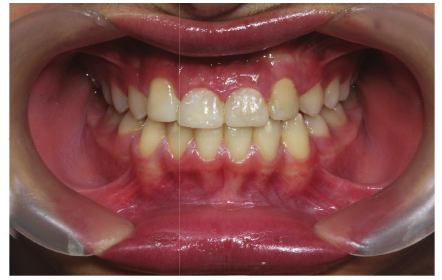
Figure 6: Gingival appearance after gingivectomy.